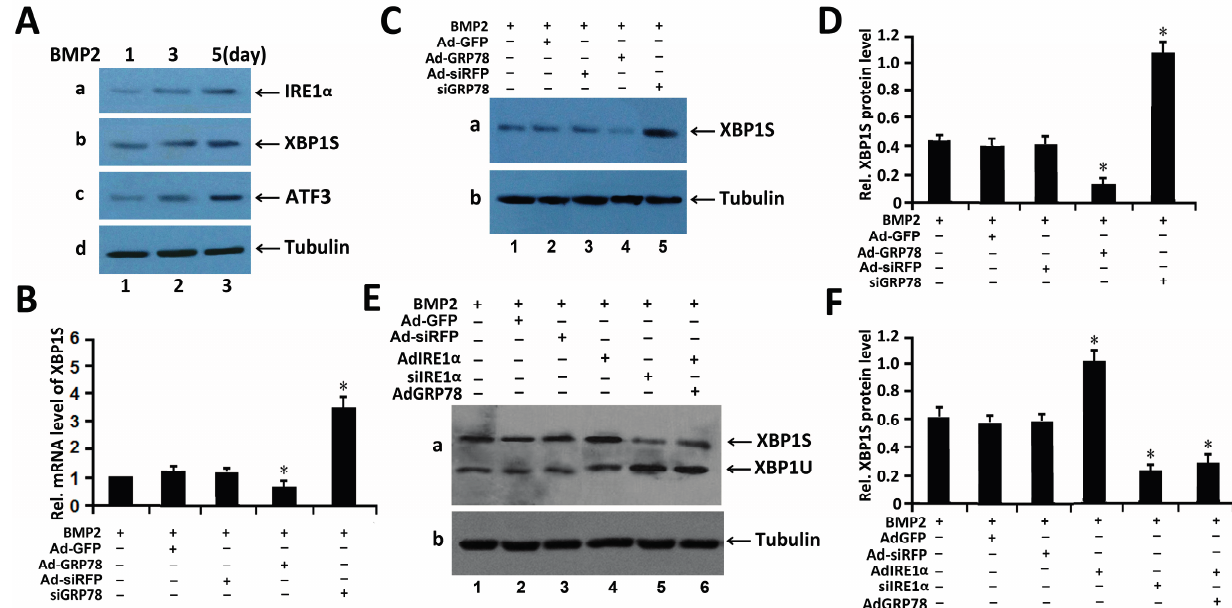
Figure 3. GRP78 decreases the expression of the XBP1S in BMP2-induced chondrogenesis. ( A ) Western blotting assay of the expression of ER stress associated molecules in C3H10T1/2 cells induced by BMP2 (300 ng/mL) for different times (1, 3, 5 days). Cell lysates prepared from micromass culture of C3H10T1/2 cells induced by BMP2, as indicated, were subjected to SDS-PAGE and detected with anti-BiP, anti-XBP1S, anti-IRE1 α and anti-tubulin (serving as an internal control), respectively. Protein levels of IRE1 α , XBP1S, ATF3 and tubulin (internal control) are shown; ( B ) Ad-GRP78 reduces, while siGRP78 increases, the level of XBP1S mRNA. C3H10T1/2 cells infected with Ad-GRP78 and control Ad-GFP, siGRP78 and control siRFP, were cultured for 48 h and endogenous XBP1S gene expression was determined by real-time PCR. The normalized values were then calibrated against the control value. The units are arbitrary, and the left bar indicates a relative level of XBP1S mRNA of 1; * p < 0.05; ( C ) Ad-GRP78 reduces, while siGRP78 increases, the level of XBP1S protein level in C3H10T1/2 cells induced by BMP2. C3H10T1/2 cells infected with Ad-GRP78 and control Ad-GFP, siGRP78 and control siRFP, were cultured for 48 h, respectively, and the endogenous XBP1S protein level was determined by Western blotting. siGRP78, an siRNA adenovirus targeting GRP78. Tubulin protein served as an internal control; ( D ) Semi-quantification of relative levels of XBP1S in micromass culture of C3H10T1/2 cells induced by BMP2. Levels were normalized against those of tubulin by MJ Opticon Monitor Analysis Software (Bio-Rad), data were expressed as means ± S.D. ( n = 3). Every treatment group was compared with control groups respectively, * p < 0.05; ( E ) Ad-GRP78 decreases the level of XBP1S protein spliced by IRE1 α in chondrocytes induced by BMP2. Micromass cultures of C3H10T1/2 cells were treated with 300 ng/mL BMP2, then C3H10T1/2 cells were infected with either Ad-GFP (serving as a control), siRFP (serving as a control), or Ad-IRE1 α , siIRE1 α , or Ad-IRE1 α + Ad-GRP78, as indicated. Five or six days later, the cell lysates were used to detect the protein level of XBP1S by Western blotting. siIRE1 α , an